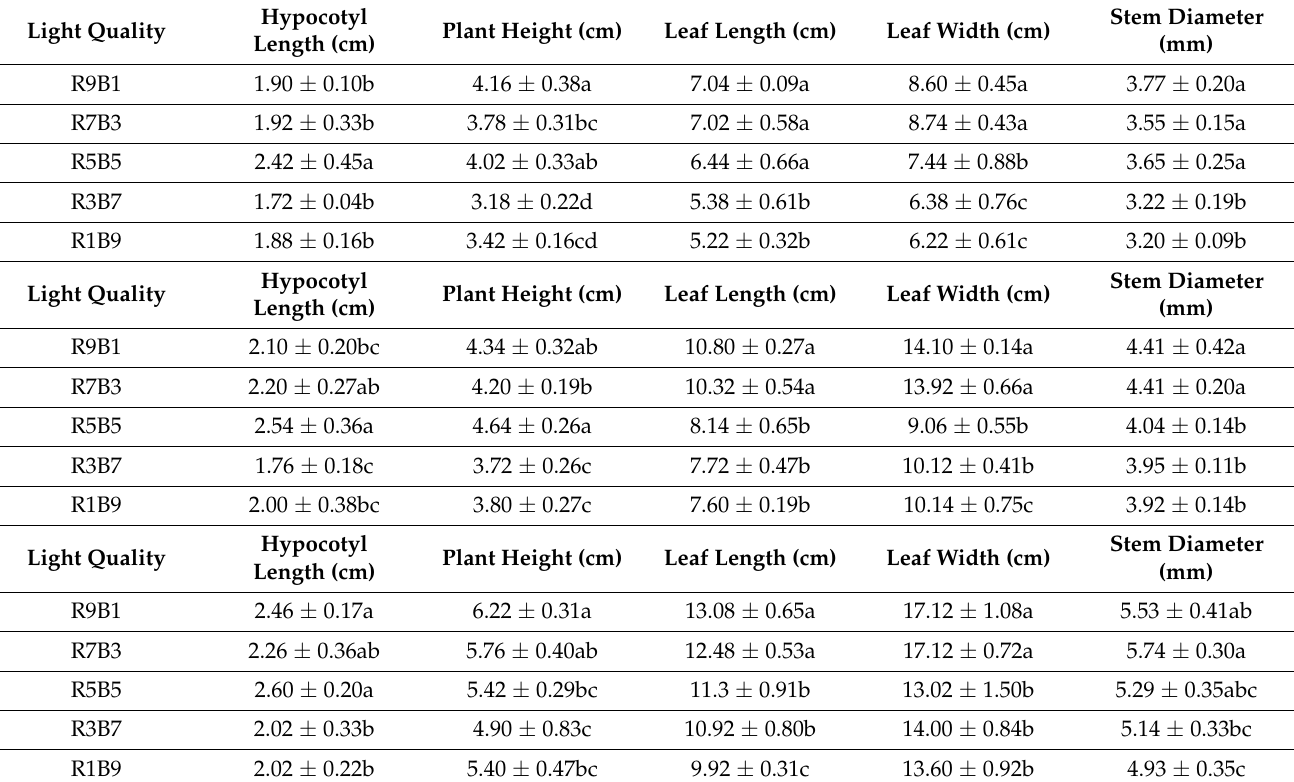
Table 1. Morphological parameters of cucumber seedlings on the 13th (2022/9/13), 16th (2022/9/16), and 19th (2022/9/19) days after sowing under the effect of blue and red light. Values are means ± standard errors. Means with the same letter within each column were not significantly different at p <